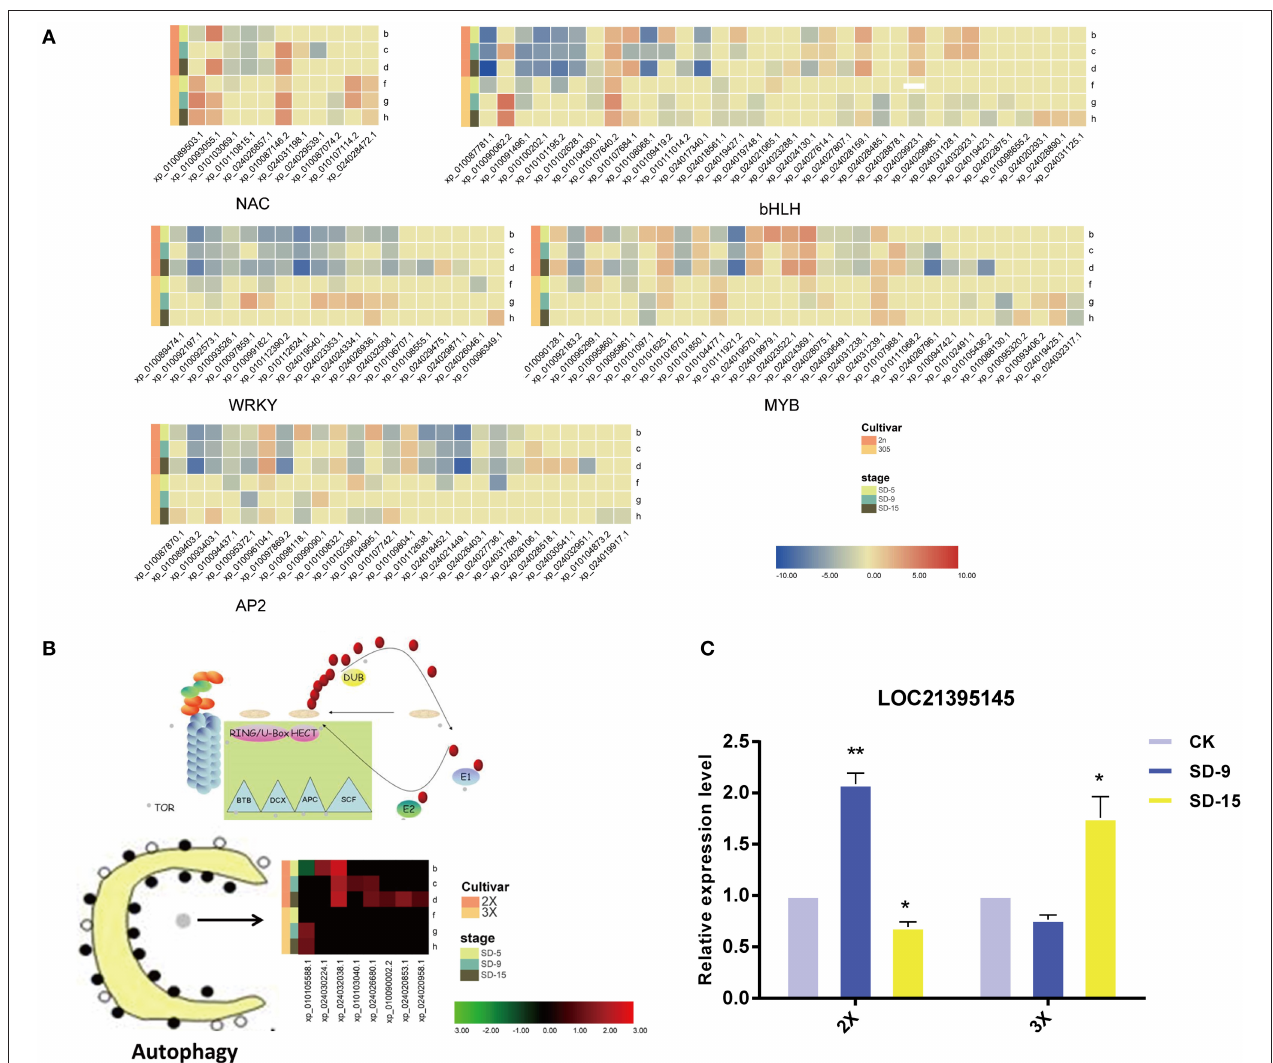
FIGURE 6 | Heatmap of transcription factor and autophagy related transcripts. (A) Heatmap of gene expression for TFs enriched. (B) Heatmap of gene expression for eight DEGs enriched in the ‘autophagy’ pathway. Heatmap color indicates fold change of expression under drought compared with that in well-watered of both diploid (2X) and triploid (3X). (C) Quantitative real-time PCR analysis of LOC21395145 gene of diploid (2X) and triploid (3X) identified in the drought treatment and control over two sampling time points (9 and 15 days). All assays were carried out at least three times and statistical significance levels were calculated using Student’s t -test (*, p ≤ 0.05;**, p ≤ 0.01). CK, control; SD, severe